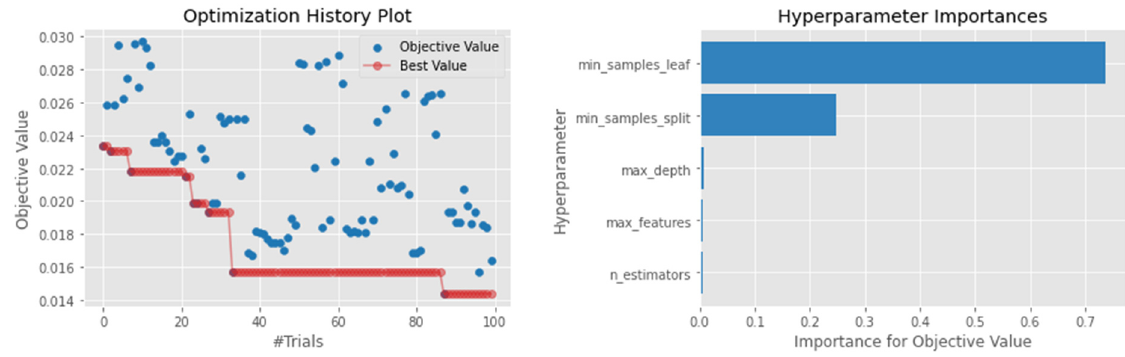
Figure 5. Hyperparameter optimization for the RF model.